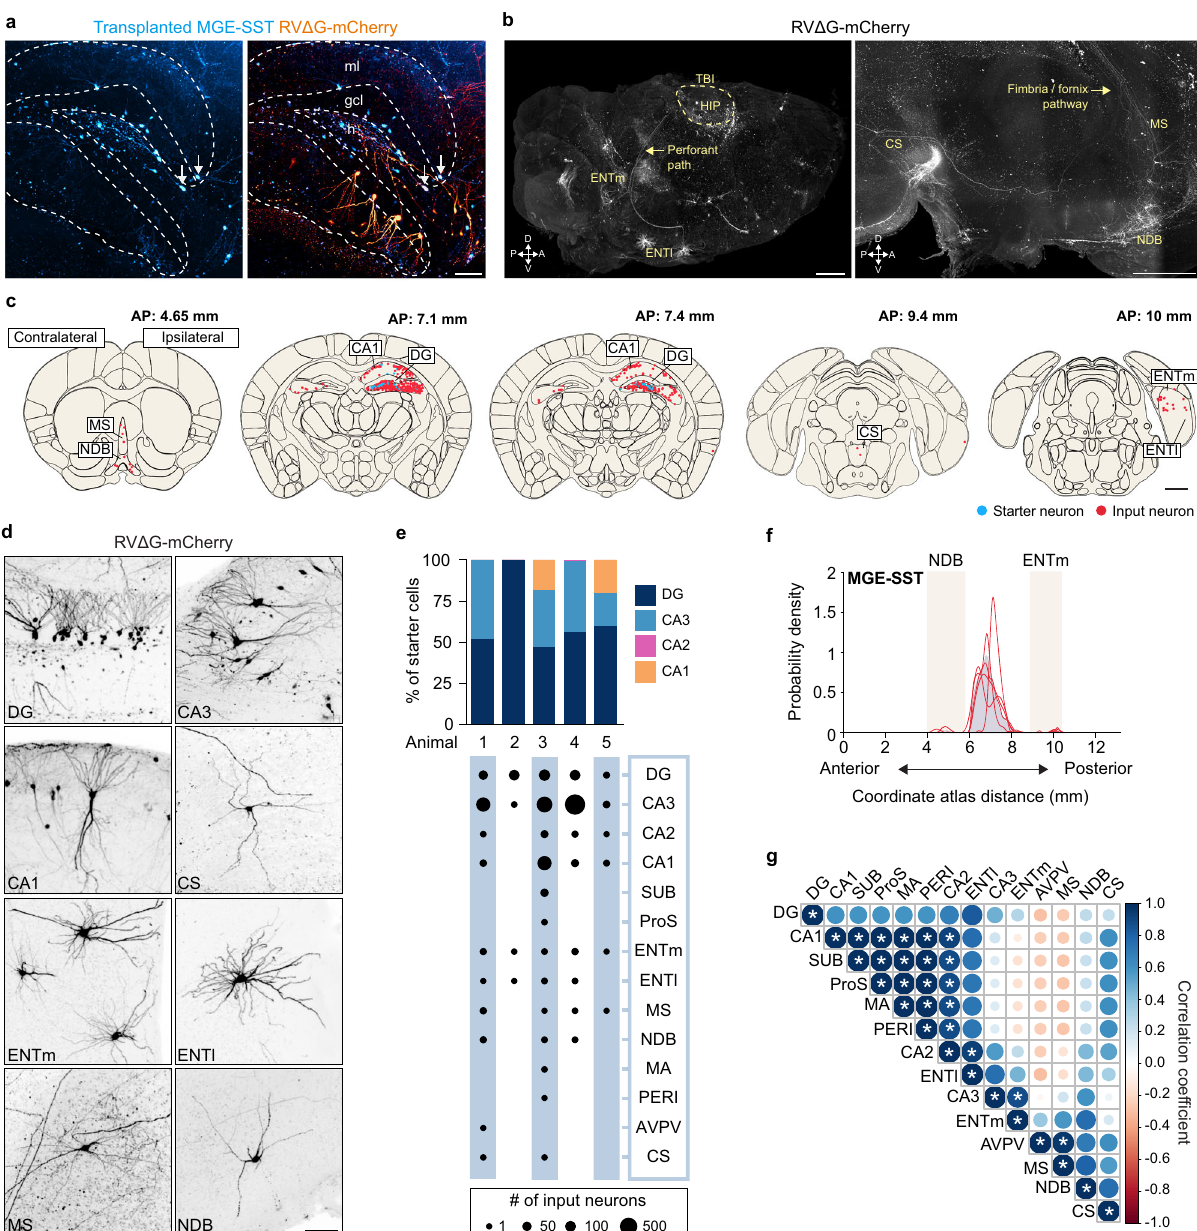
Fig. 8 Transplanted SST interneurons receive local and long-range input. a A 100 μ m sagittal optical section of dentate gyrus labeled for transplanted cells (blue) and input neurons (orange). White arrows, starter cells. h, hilus; gcl, granule cell layer; ml, molecular layer. b Left: whole-brain render of the entire ipsilateral hemisphere of the same animal shown in (a) labeled for input neurons (white). Dotted circle outlines the injury border overlying hippocampus (HIP). Right: Whole-brain render showing input neurons in superior central nucleus raphae (CS), medial septum (MS), and diagonal band nucleus (NDB). Representative animal from n = 5 mice. c Schematic coronal sections (250 μ m) showing individual starter cells (red) and input neurons (blue) registered in standardized atlas space. One dot represents one neuron. n = 5 animals. d Maximum intensity projections (100 μ m) of neurons providing input to transplanted SST interneurons in the intact injured brain. Representative animals from n = 5 mice. e Top: proportion of transplanted starter cells found in each layer of hippocampus. Bottom: bubble plot of brain areas containing rabies-labeled input neurons. f Gaussian kernel cell density plot of the whole-brain distribution of input neurons along the anterior-posterior axis. Grey shading represents the pooled population with individual lines representing each animal. g Correlation matrix of input to transplanted SST interneurons. Size and color, correlation coef fi cient. * P < 0.05, exact P-values are provided in Source Data fi le; two-sided Pearson ’ s correlation. Scale bars, 100 μ m ( a, g ), 1 mm ( b, c ). A list of abbreviations is provided in Supplementary Data 2. See also Supplementary Fig. 16 and 17, Source Data and Supplementary Movie 5. Source data are provided as a Source Data fi